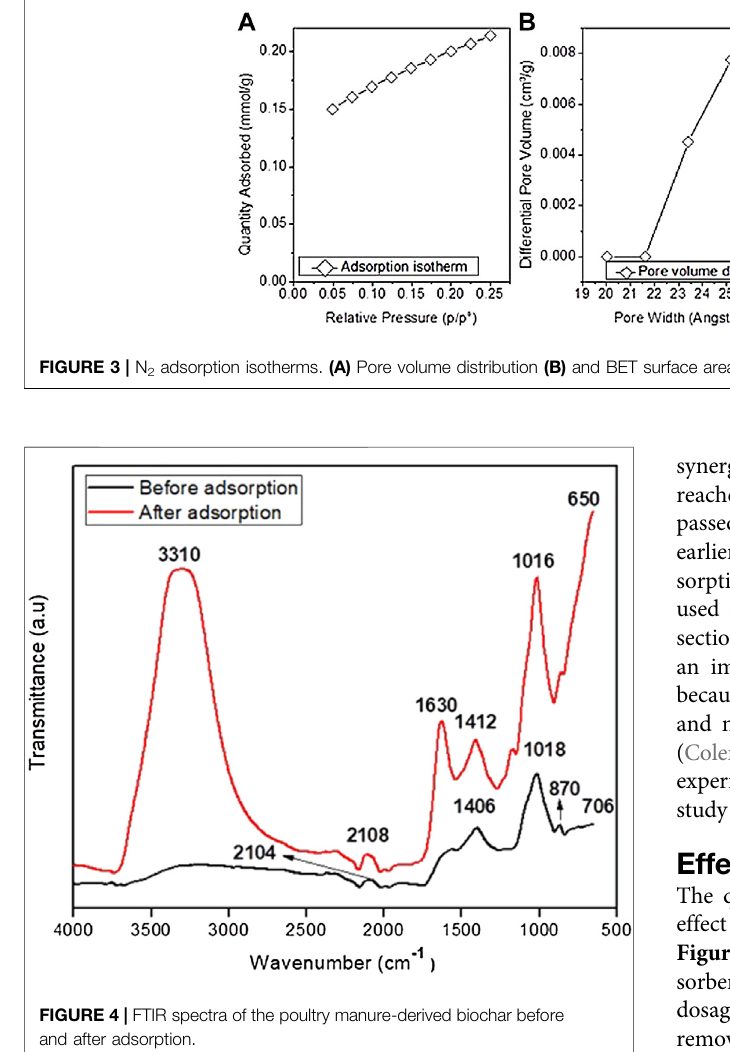
Frontiers in Environmental Science |